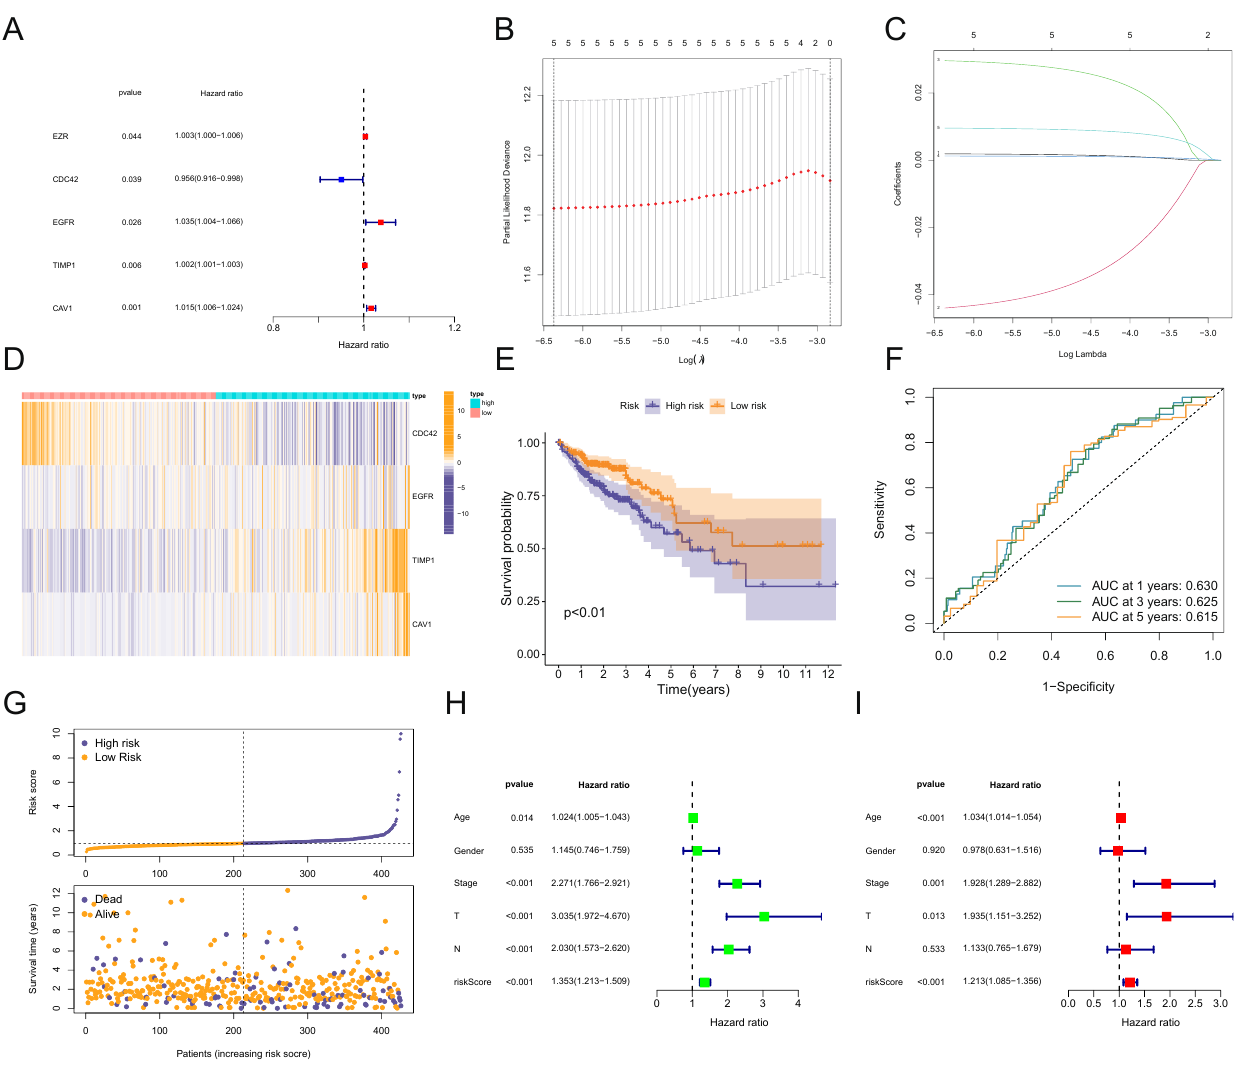
Figure 3. Construction of the prognostic risk model based on the TCGA-COAD cohort: ( A ) Forest map of 5 MTRGs significantly correlated with OS, identified by univariate cox analy- sis. ( B ) Screening of optimal parameters (lambda) in the LASSO regression model based on the TCGA cohort. ( C ) LASSO coefficient profiles of the 4 MTRGs determined by the optimal lambda. ( D ) Heatmap of the expression of 4 MTRGs in high- and low-risk groups. ( E ) Kaplan–Meier curve for the OS of colon cancer patients in the high- and low-risk groups in the TCGA cohort. ( F ) ROC analysis of the prognostic model for OS and survival status in the TCGA cohort. ( G ) Scatterplots in the top and bottom illustrate the distribution of the risk score and survival status in the colon cancer patients, respectively. ( H , I ) Univariate ( H ) and multivariate ( I ) Cox regression analyses of the risk score and clinicopathological parameters in the TCGA